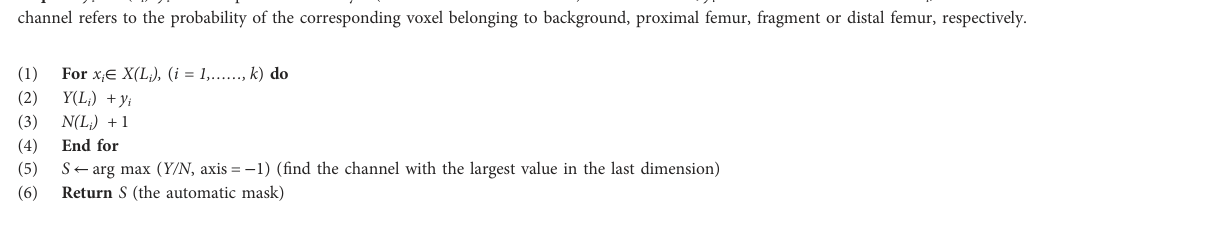
Algorithm 1: Combined